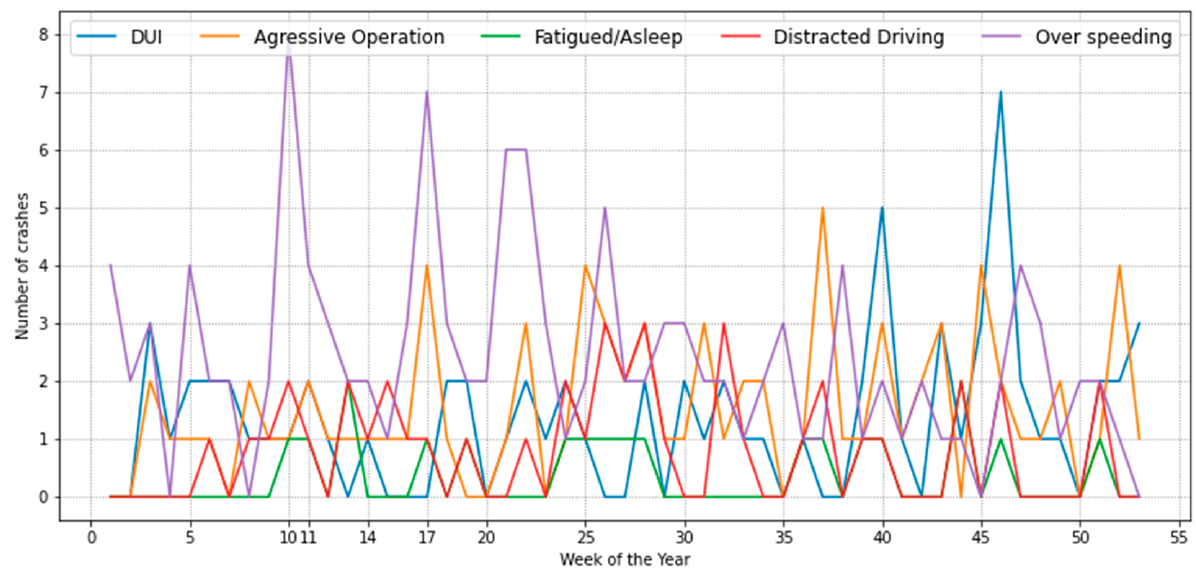
Figure 4. Distribution of fatal crashes by primary contributing factors.